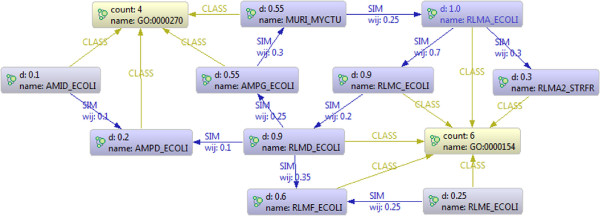
A sample Neo4j net. A graphical representation of a sample Neo4j net.